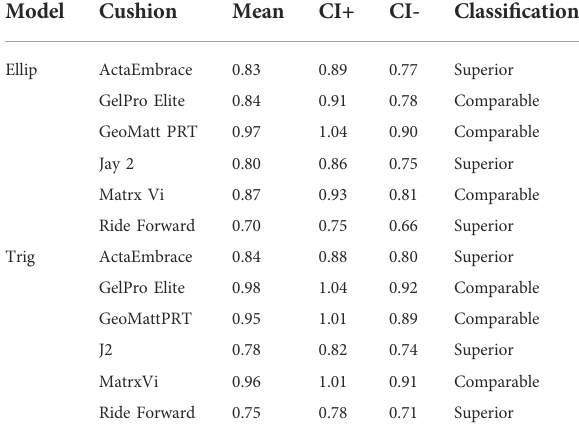
TABLE 5 Pressure Magnitude classi fi cations of Skin Protection